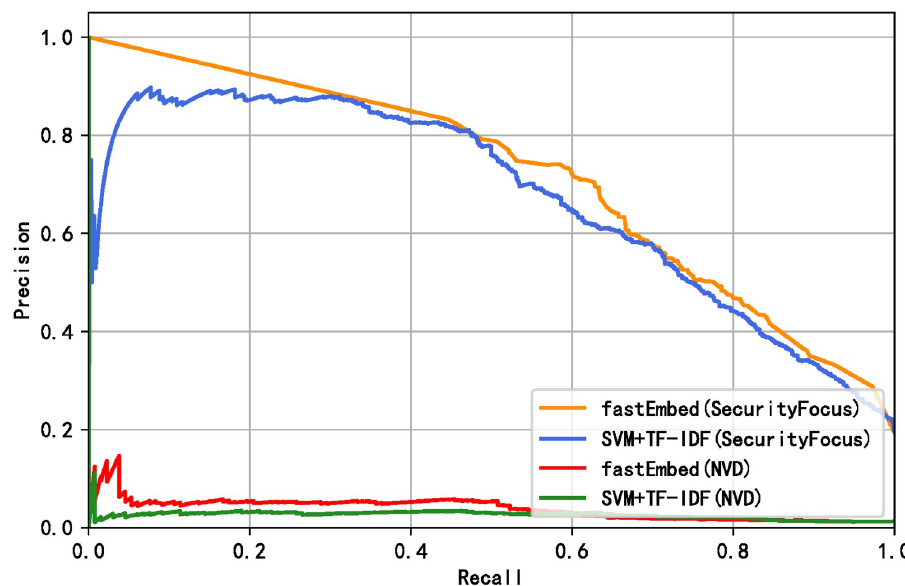
Fig 10. Precision-Recall curve of baseline model and fastEmbed without temporal intermixing.